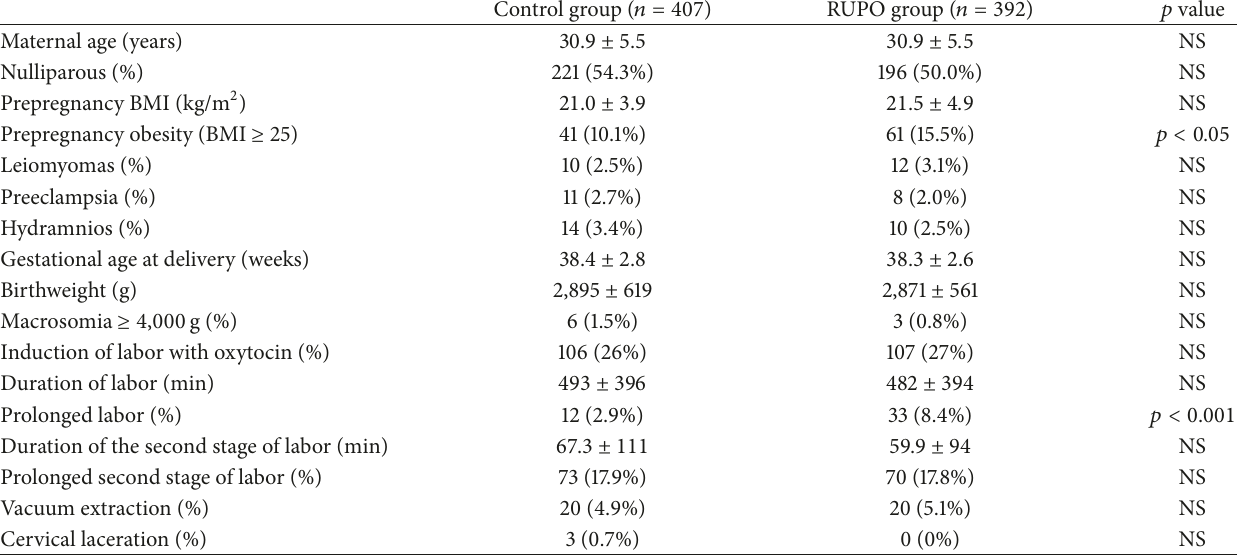
Table 1: The maternal characteristics and perinatal outcomes in each group.